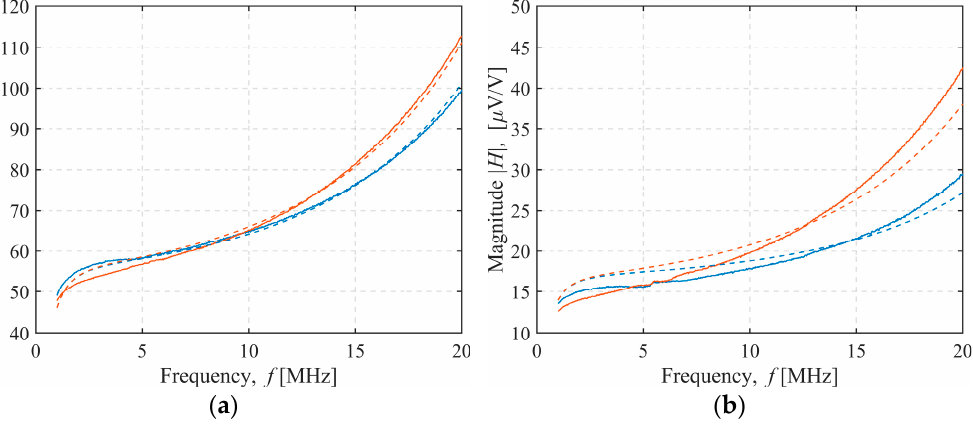
Figure 10. TX X-4/RX X-4 configuration sensor transfer function magnitude. Transmitter–receiver separation: ( a ) 27 cm, ( b ) 37 cm. Measurement (full line) and model results (dashed line). Transmitter orientation up (blue line) or down (red line).